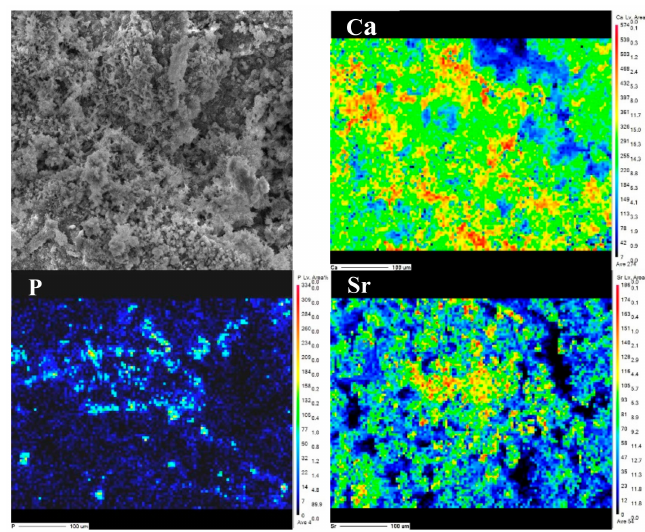
Figure 5. The EPMA analysis for Ca, P and Sr element distribution on the surface of